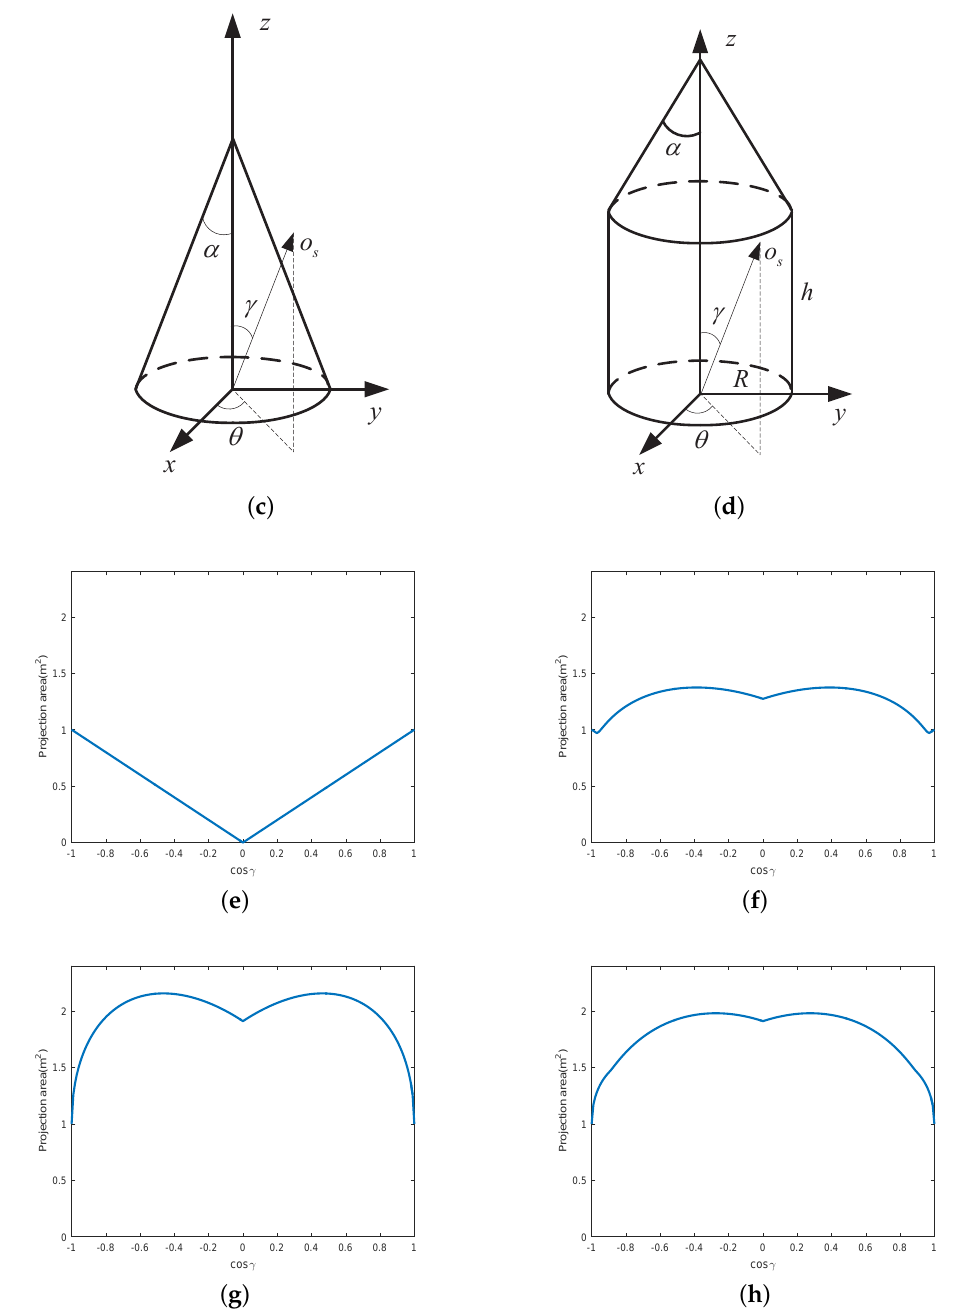
Figure 3. Illustration of the projection function for different shapes. ( a ) shows the projection geometry of the plane; ( b ) shows the projection geometry of the cylinder; ( c ) shows the projection geometry of the cone; ( d ) shows the projection geometry of the cone–cylinder; ( e ) shows the projection function of the plane; ( f ) shows the projection function of the cylinder; ( g ) shows the projection of the cone; and ( h ) shows the projection function of the